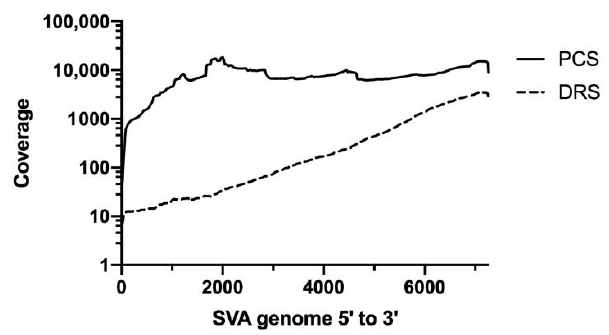
Figure 1. Coverage distribution of the direct RNA sequencing and PCR-cDNA sequencing. SVA reads were mapped to a reference genome using Minimap2 and analyzed by Qualimap to generate a coverage information file which was then visualized using GraphPad prism software. The dashed line represents the distribution of the direct RNA sequencing reads (DRS) and the solid black line represents the distribution of the PCR-cDNA sequencing reads (PCS).